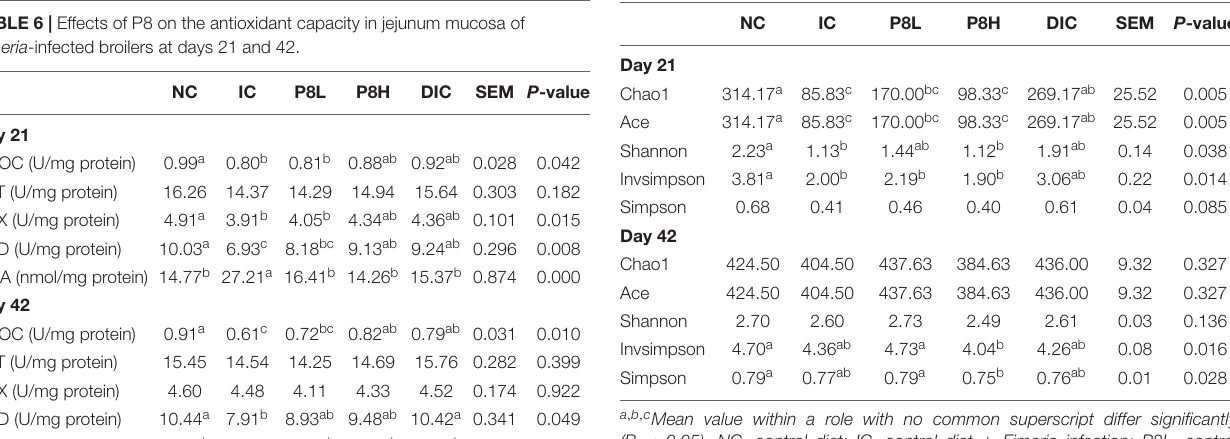
TABLE 8 | Effects of P8 on the α -diversity of gut microbiota of Eimeria -infected broilers at days 21 and